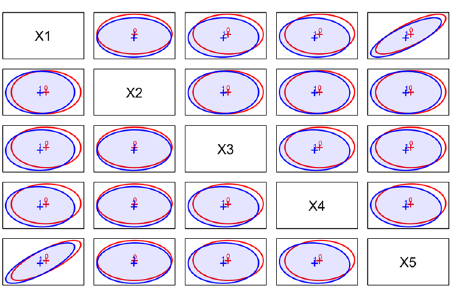
Figure 3: Variance – covariance preservation in the simulation set - up highlighted with pairwise covariance ellipses for one realization of the simulation ( package heplots ) .